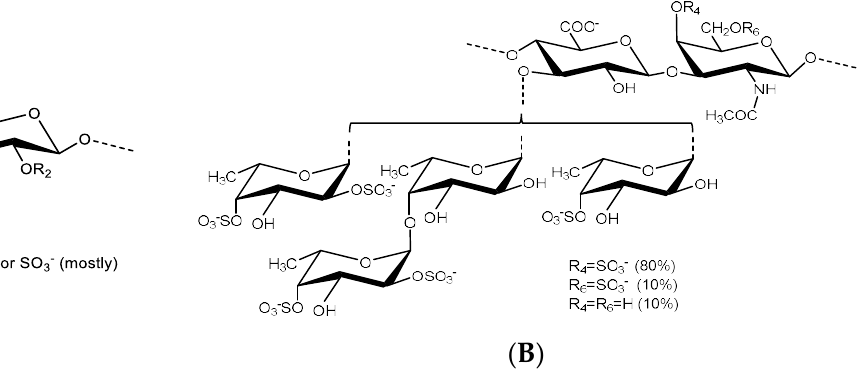
Figure 1. Structural representation of sulfated glycans assayed for anti-HCMV activity. ( A ) Unfrac- tionated heparin (UFH) is mostly composed of repeating disaccharide units of [ → 4)-α-GlcN-(1 → 4)- α-IdoA-(1 → ] where GlcN is glucosamine and IdoA is iduronic acid. Sulfation occurs frequently at the N- and C6-positions of GlcN and C2 position of IdoA. ( B ) PpFucCS is constituted of a chondroitin sulfate backbone that alternates N-acetylgalactosamine (GalNAc) and glucuronic acid (GlcA) in repeating disaccharide units of [ → 3)- β -GalNAc-(1 → 4)- β -GlcA-(1 → ], where the GalNAc units are primarily 4-sulfated (80%) and, to a very less degree, 4,6-disulfated (10%) or nonsulfated (10%). The GlcA units are replaced at the C3 position by three different forms of α-fucose (Fuc) branches: Fuc2,4S-(1 → (40%), Fuc2,4S-(1 → 4)-Fuc-(1 → (30%), and Fuc4S-(1 → (30%); where S = SO 3− .